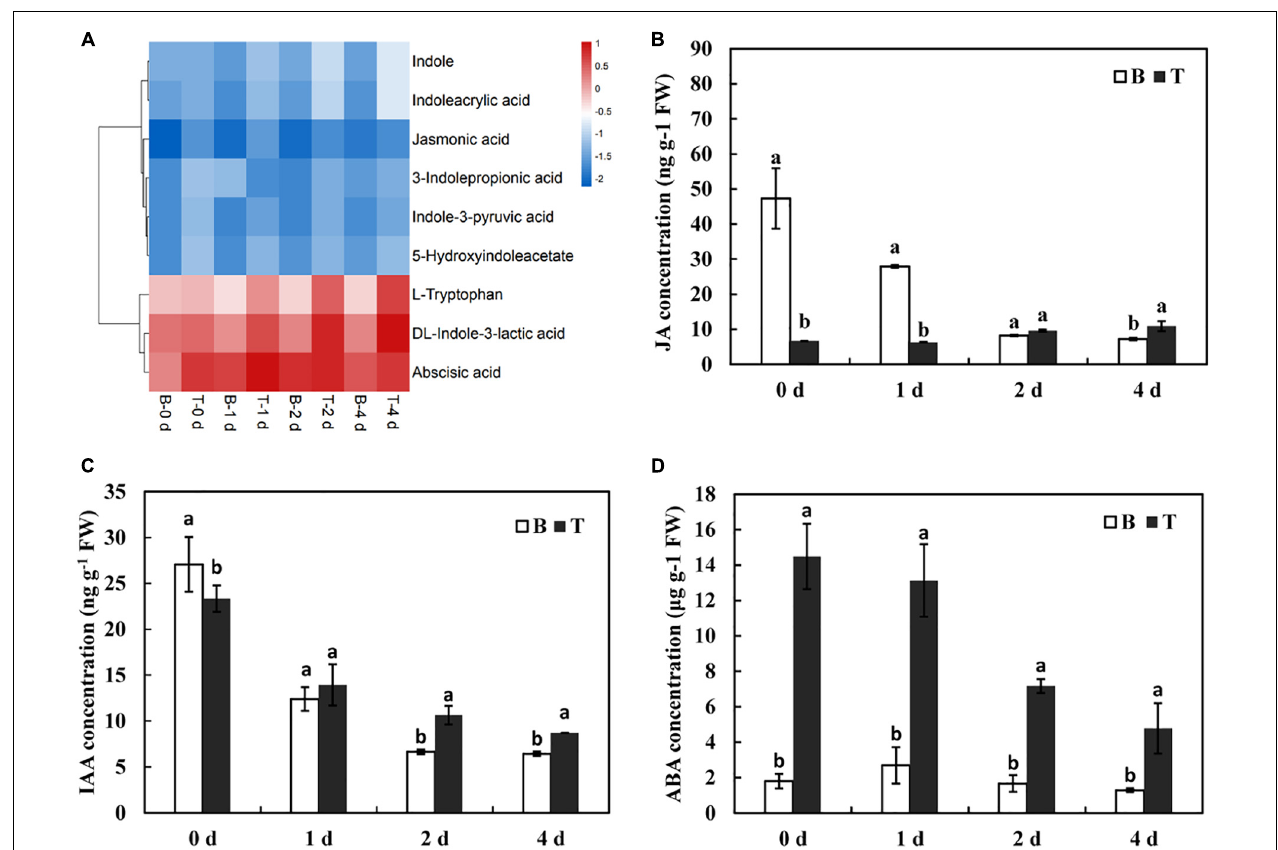
FIGURE 6 | Changes of phytohormone contents during the in vitro dodder growth. (A) The cluster heatmap of phytohormones-related metabolites by the metabolomics data. (B–D) The variations of JA (B) , IAA (C) , and ABA (D) contents in the in vitro dodder shoots by LC-MS/MS. Values are means, and the vertical error bars are SD ( n = 3). Different letters in each panel represent significant difference protected with Fisher’s LSD at P <